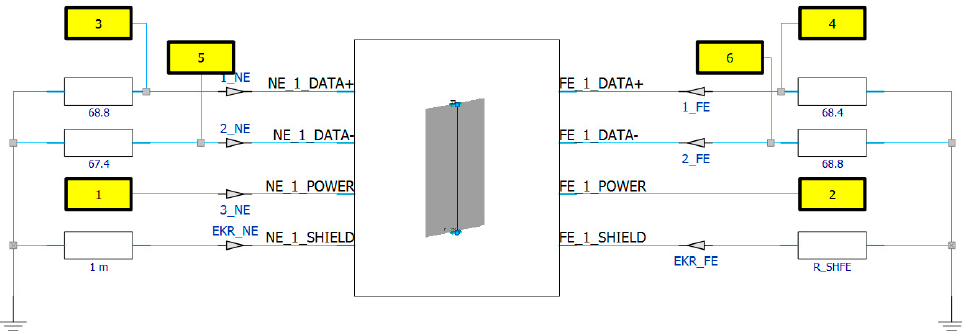
Figure 10. The circuit diagram of the tested system.